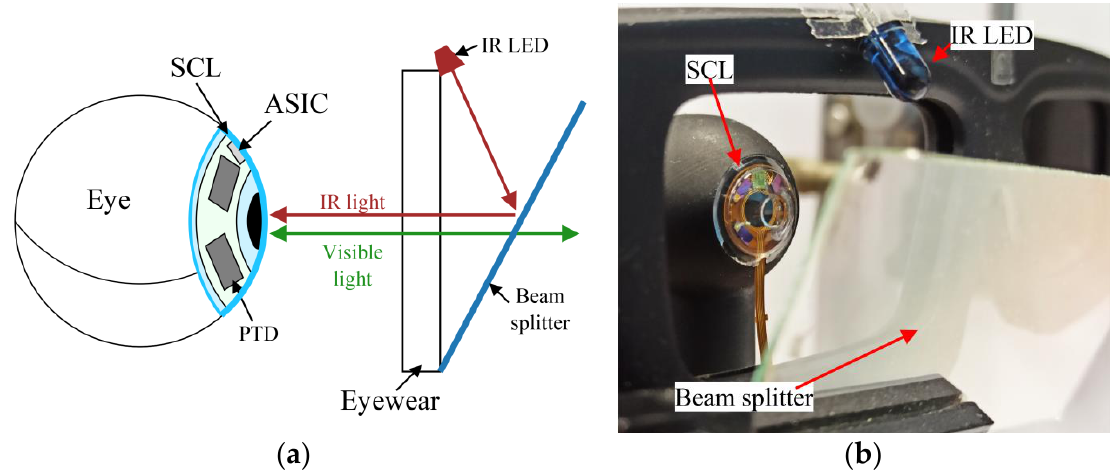
Figure 6. Deporting IR light source on the eyewear: ( a ) principle, ( b ) actual realization.